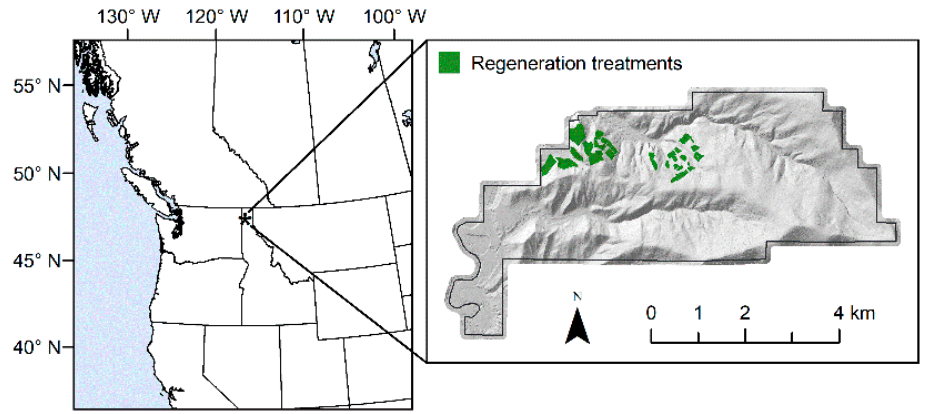
Figure 1. Priest River Experimental Forest (PREF) in northern Idaho, USA, and location of the Free Selection Silviculture study (green blocks) within PREF.